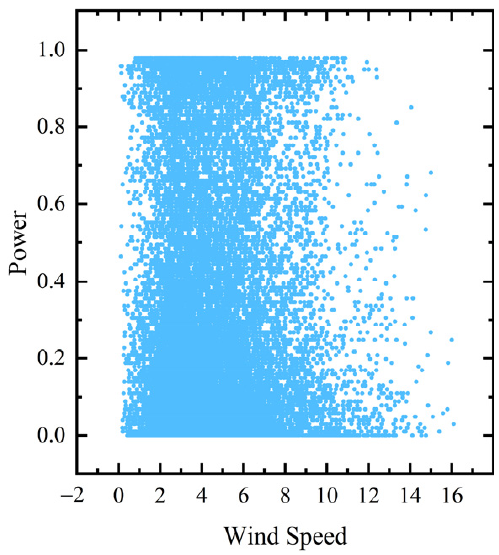
Figure 3. Wind power curve of WF3 under 1-h sampling rate. The blue points refer to the sampling moments. The vertical coordinates of the blue points indicate the wind power measurement values at the sampling moments, and the horizontal coordinates of the points are the corresponding wind speed data.